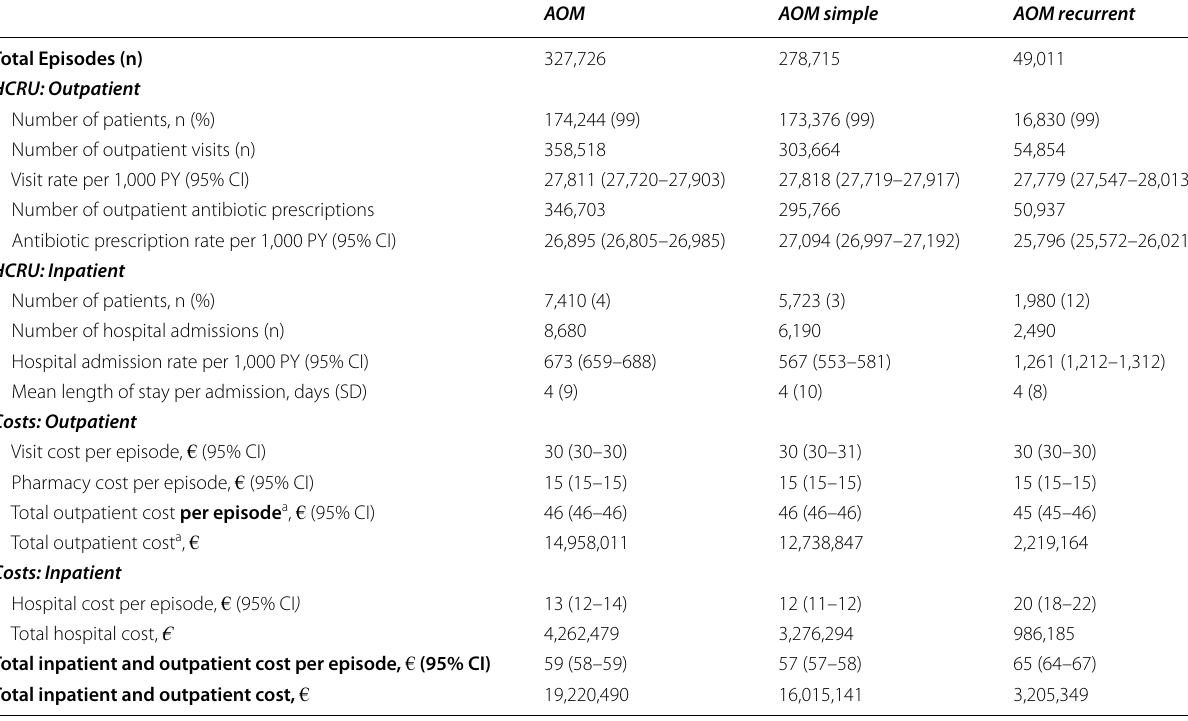
Table 3 HCRU and costs associated with AOM in patients with at least one episode overall during 2014 to